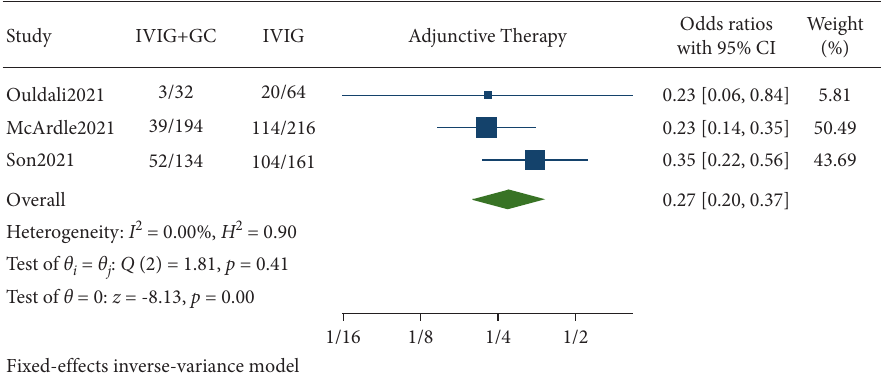
Figure 3: Forest plot showing the comparison of need of adjunctive therapy in IVIG plus glucocorticoids versus IVIG.